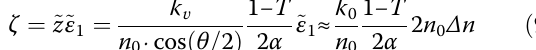
Fig. 4 Wave-vector diagram of self-diffraction of two coherent ! k ! waves (described by k 0 and 1 ) in the Raman-Nath